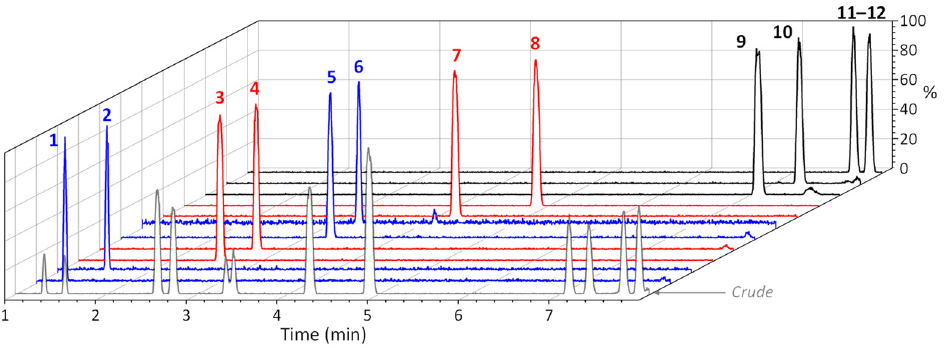
Figure 4. UHPLC-HRMS chromatograms (EIC m / z 1469.6260) of the isomers mixture and of the 11 purified fractions obtained by preparative chromatography. It should be noted the 12 isomers are labelled by their elution order: 1 , 2 , 3 …. 12.